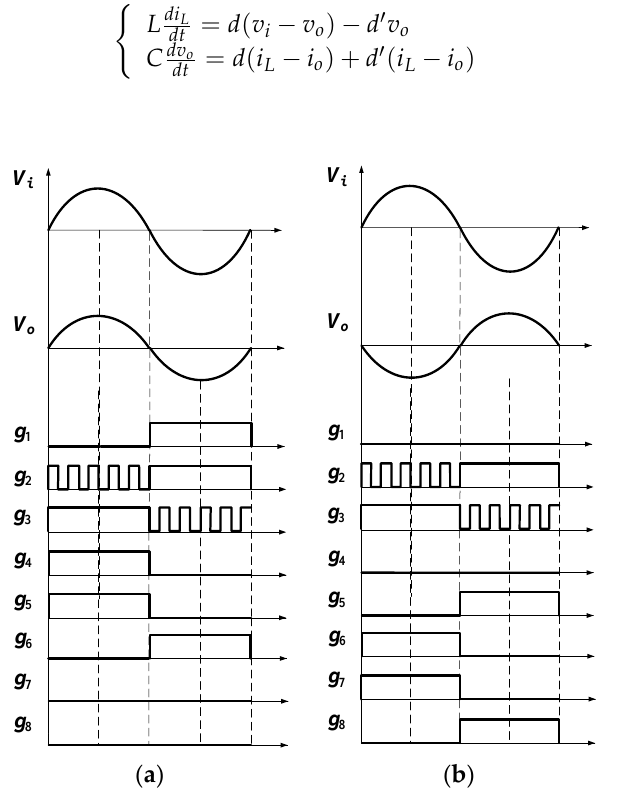
Figure 2. Gating sequences for: ( a ) buck operation for positive voltage gain; ( b ) buck operation for negative voltage gain.